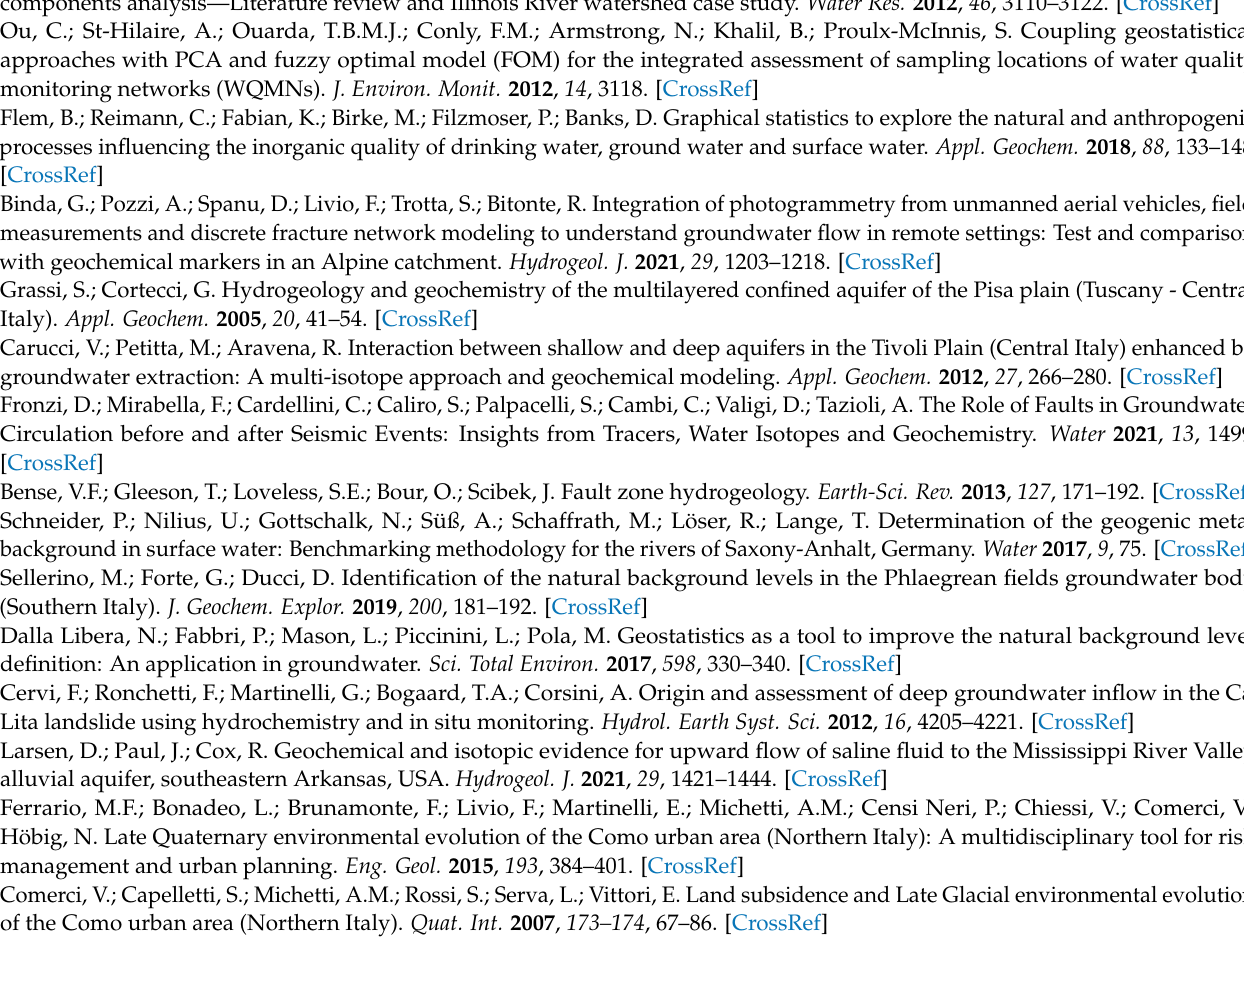
Table S1: Location and type of water sampled in different sampling points, Table S2: Physicochemical parameters and major ion data of all water samples, including ion balance, Table S3: Trace element concentration and isotopic values of all water samples, Table S4: Concentration of different metals in the sediment samples (average values of 3 replicates, relative standard deviation <